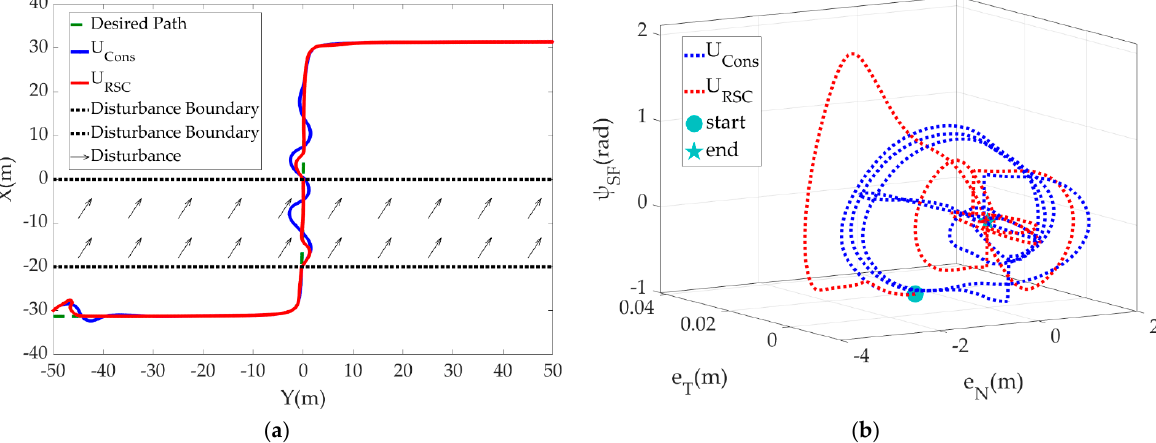
Figure 3. Results of USV path following for C 1: ( a ) Perspective in the inertial coordinate system; ( b ) Perspective in the Serret-Frenet coordinate system.